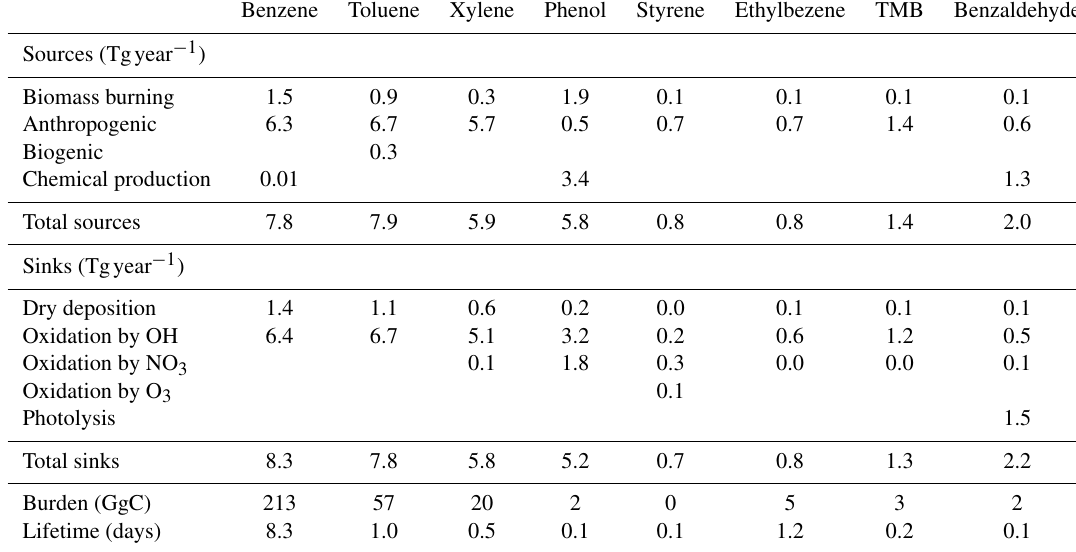
Table 5. Global atmospheric budget of aromatic compounds from the RCP simulation. Units are TgCyear − 1 in all cases, unless noted otherwise. Benzene Toluene Xylene Phenol Styrene Ethylbezene TMB